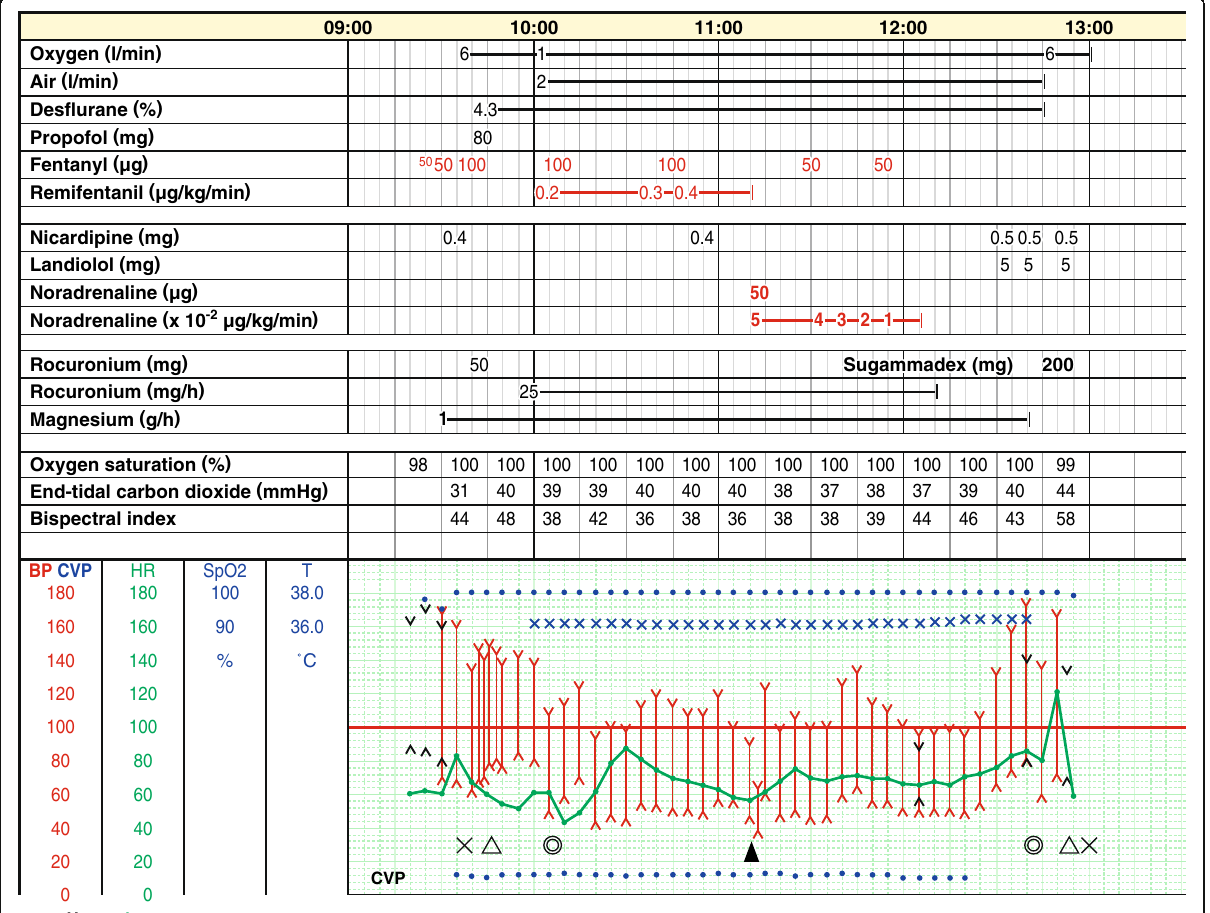
Fig. 2 Anesthesia record. X, start and end of anesthesia; Δ , tracheal intubation and extubation; ◎ , start and end of surgery; ▲ , resection of the